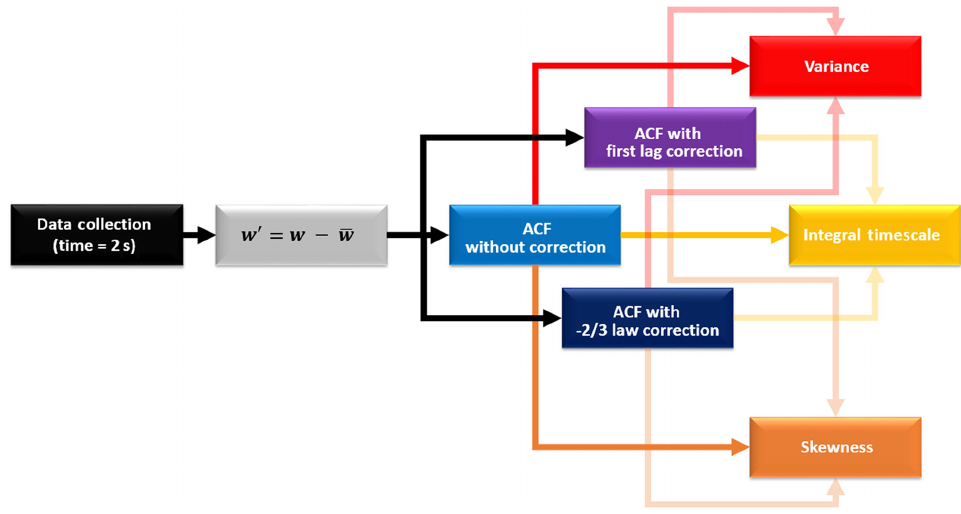
Figure 2. Flowchart of data analysis methodology applied to the study of turbulence with Doppler lidar.